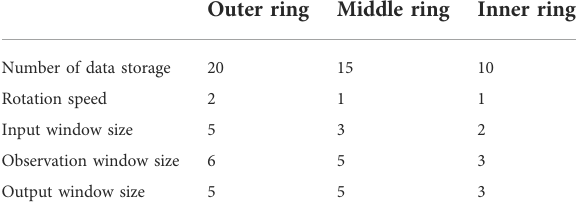
TABLE 1 Parameter settings of the MRM